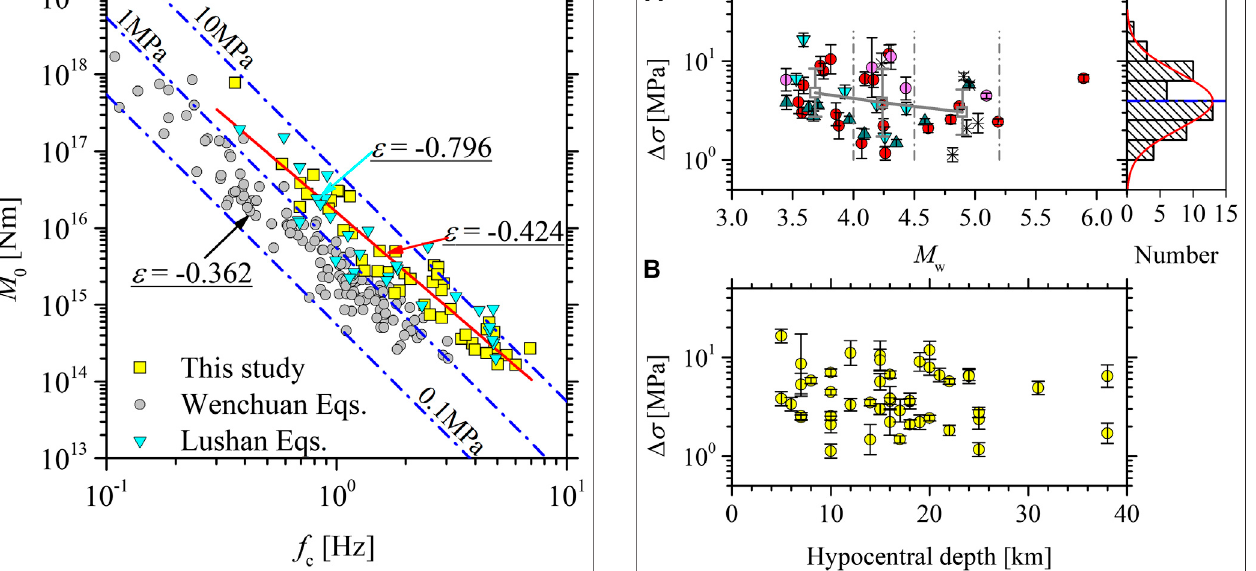
FIGURE 8 | Stress drop ( Δ σ ) as a function of moment magnitude ( M w ) (A) and hypocentral depth (B) . Red circles and dark cyan triangles represent earthquakes in the 2020 and 2018 Jiashi seismic sequences, respectively. Lightmagentacirclesandlightcyantrianglesrepresentearthquakesthat formerly occurred in proximity to the seismogenic regions of the 2020 and 2018 sequences, respectively. Other earthquakes considered are marked by crosses. The lognormally distributed Δ σ values are found from the